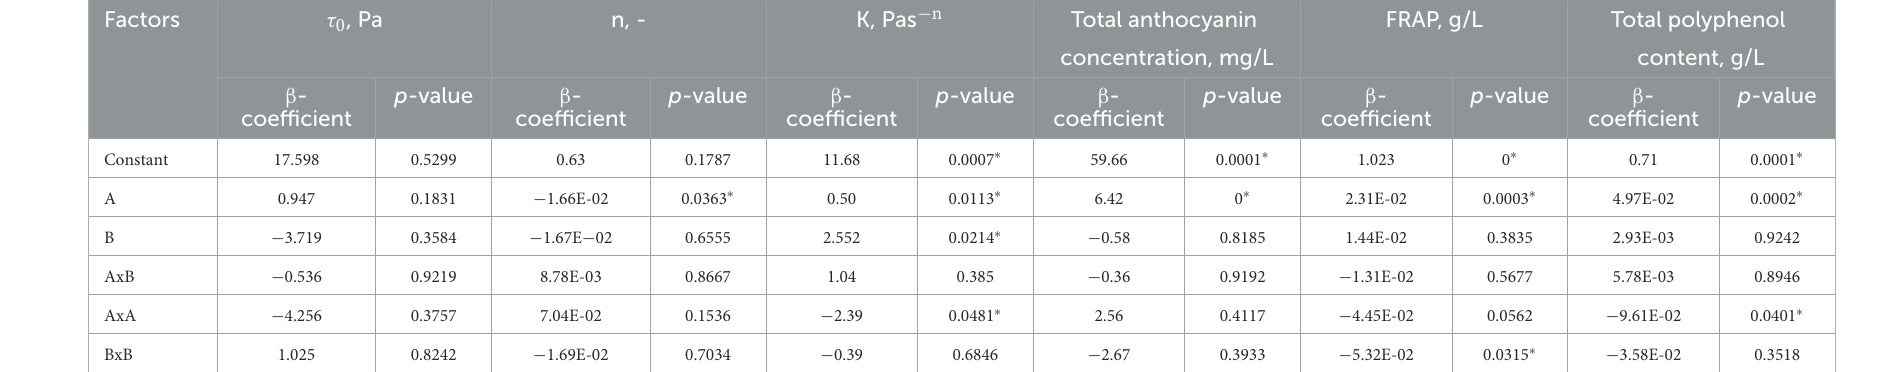
TABLE 4 The regression coefficients of the quadratic polynomial model for response analysis with encoded units.